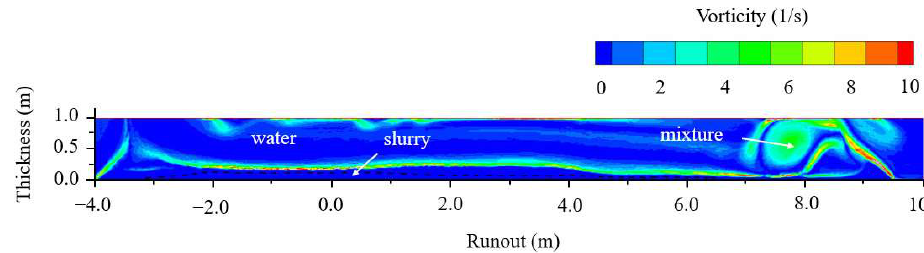
Figure 9. Vorticity contour at 15 s.